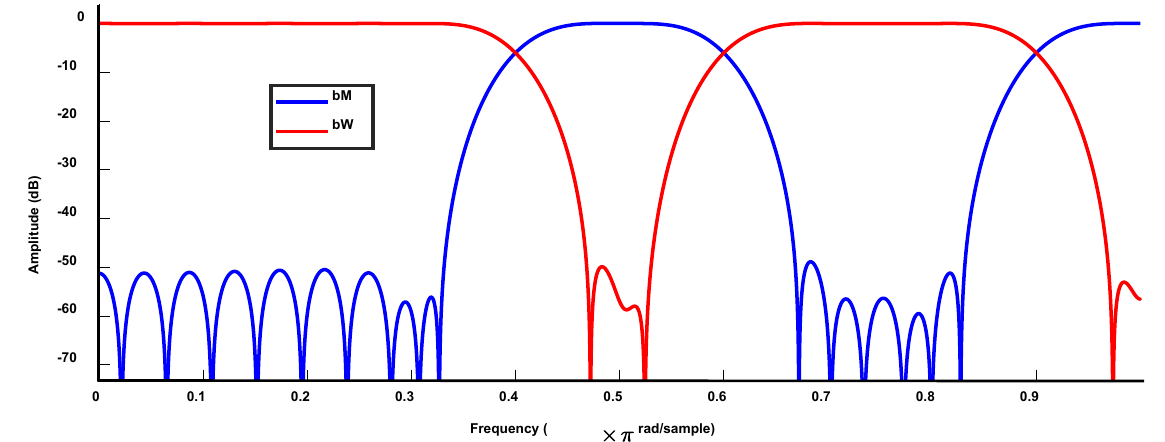
Figure 10. The example amplitude response of the FIR-I filter (Attenuates normalized frequencies below 0.4π rad/sample and between 0.6π and 0.9π rad/sample). The filter was a FIR1 type bandpass filter. By filtering the primary frequencies indi- vidually, the response signals at each frequency were obtained. The parameters of the filter are shown in Table 3. Table 3. The frequency and the filter band for designing the FIR-I filter. Frequency (Hz)